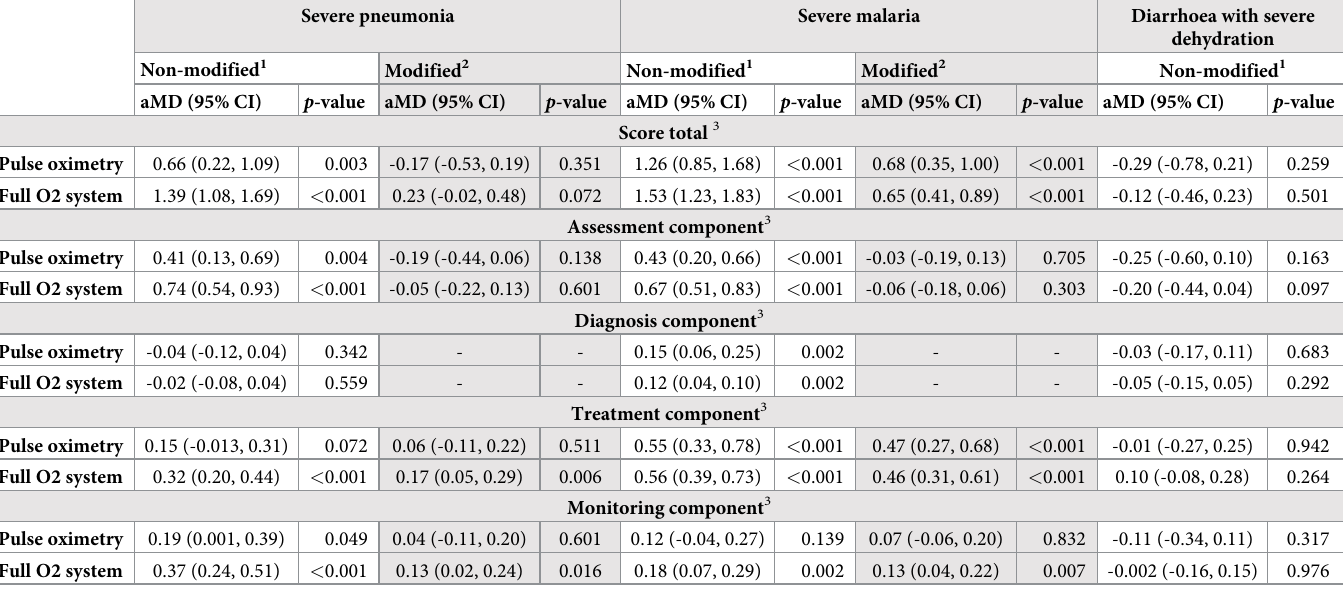
Table 3. Effect of the intervention on non-modified and modified mean QOC score totals and components, comparing the pulse oximetry and full oxygen system periods to baseline (see S3 Table for restricted analysis comparing full oxygen system period to pulse oximetry